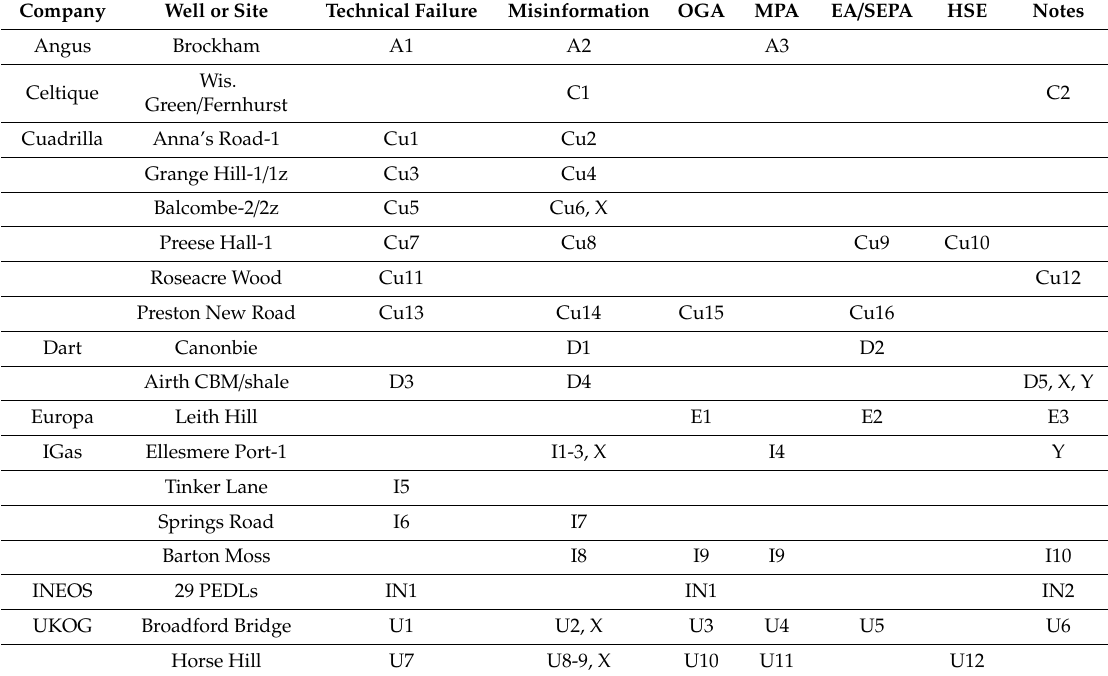
Table 2. Summary of regulation of operating